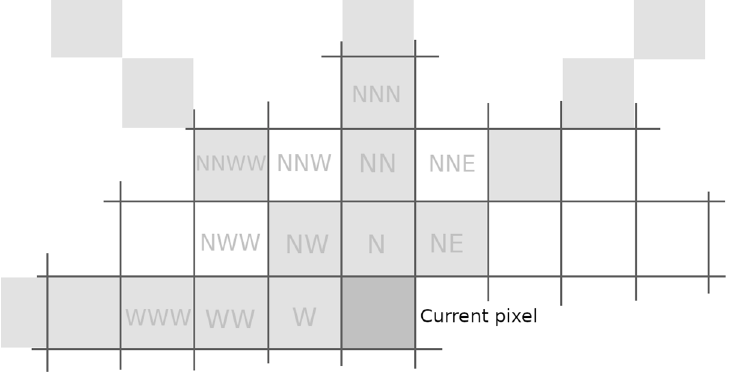
Figure 4. Contexts as rays.